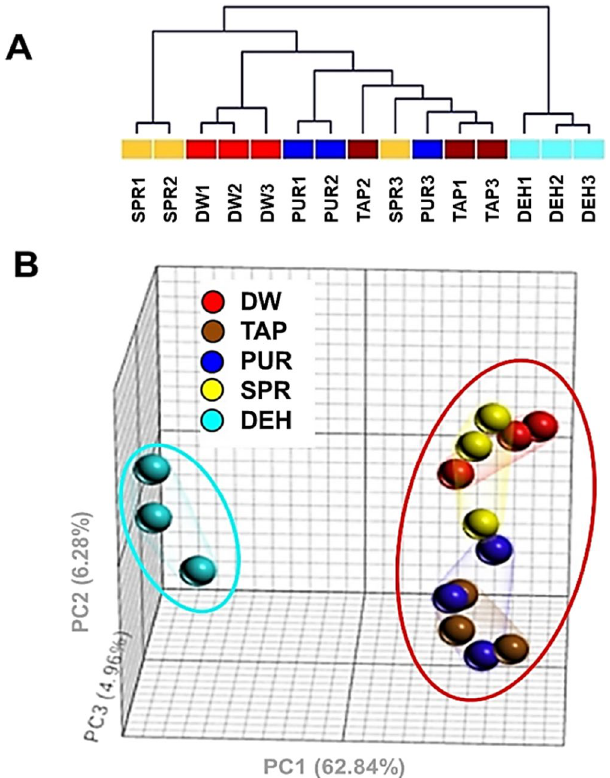
Figure 6. Effects of different drinking water types on transcriptome profiles in kidney. ( A ) Hierarchical clustering and ( B ) a 3-D view of principal component analysis (PCA) of differentially expressed genes (DEGs). Each color and ball represent the transcriptome corresponding to an individual mouse. The DEGs corresponding to the experimental groups were identified using one-way ANOVA ( p <